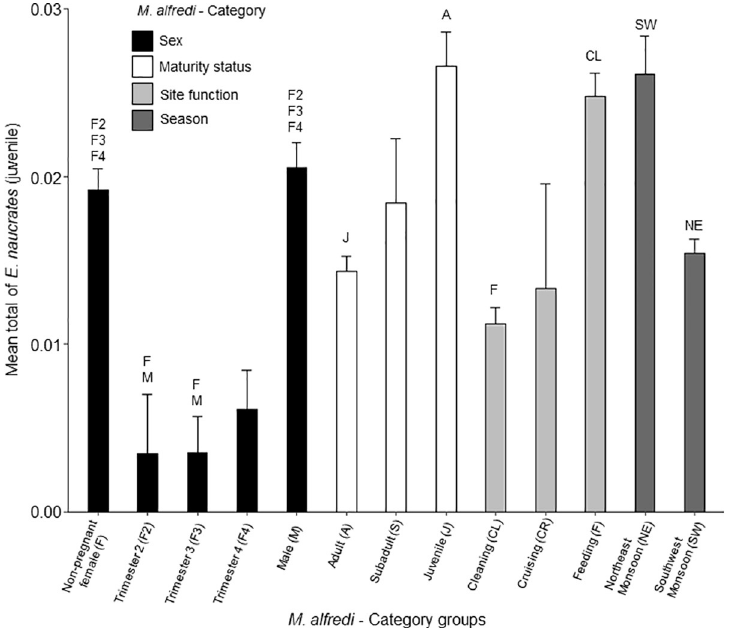
Fig 5. Daily mean number of juvenile Echeneis naucrates (+SE) observed with Mobula alfredi between category groups. Each category is coloured as per legend with group name below each bar. Letters above each bar correspond to those in brackets after the group name and indicate the groups with a significant difference ( p <